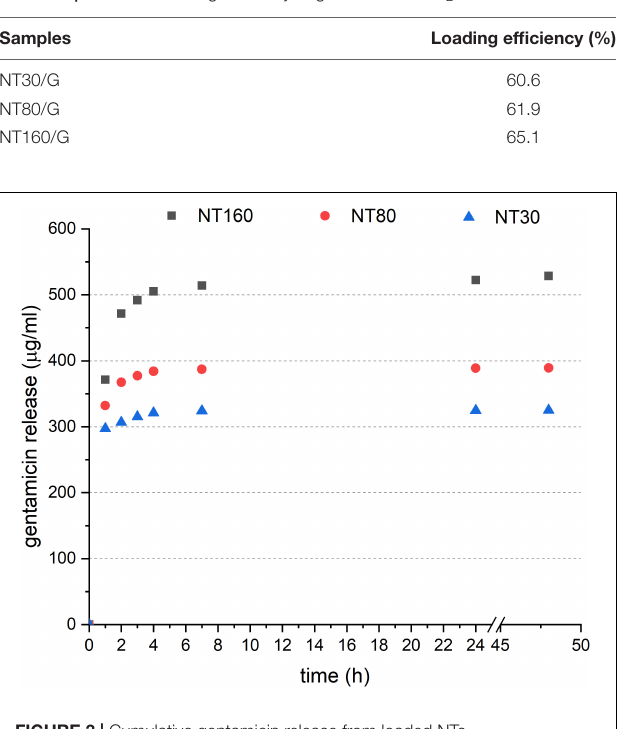
FIGURE 3 | Cumulative gentamicin release from loaded NTs.